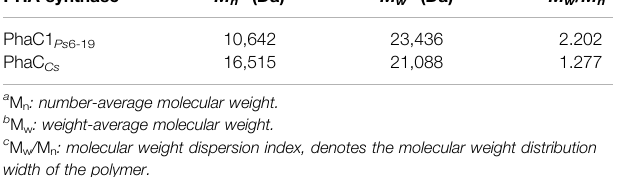
TABLE 2 | Gel permeation chromatography (GPC) of PLA synthesized by strains with different PHA synthases. PHA